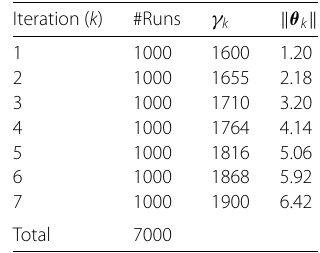
Table 1 Memory cell: ISMC exploration phase Iteration ( k ) #Runs γ k (cid:21) θ k